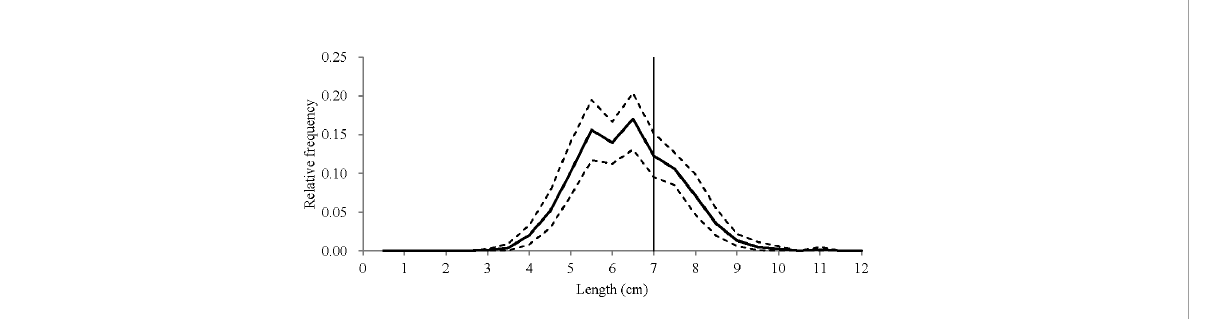
FIGURE 3 Estimated average population of cocktail shrimp from all the hauls during the sea trials. Stipple lines show the 95% Efron con fi dence intervals, and the vertical line represents the minimum conservation reference size (7.0 cm) of the target shrimp.